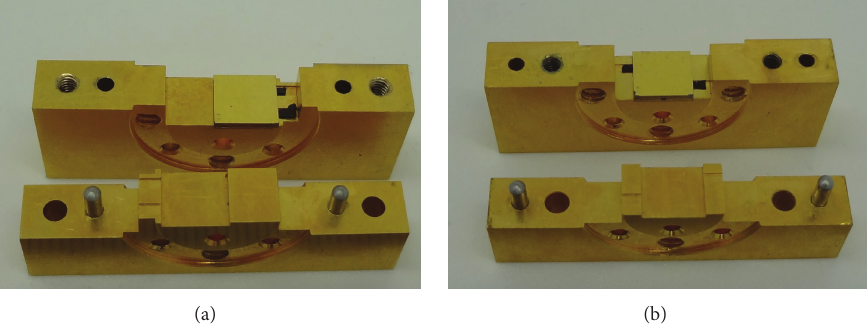
Figure 10: Test fixtures (a) for measuring the isolation topology and the through coupling topology (b) for measuring the parallel coupling topology.